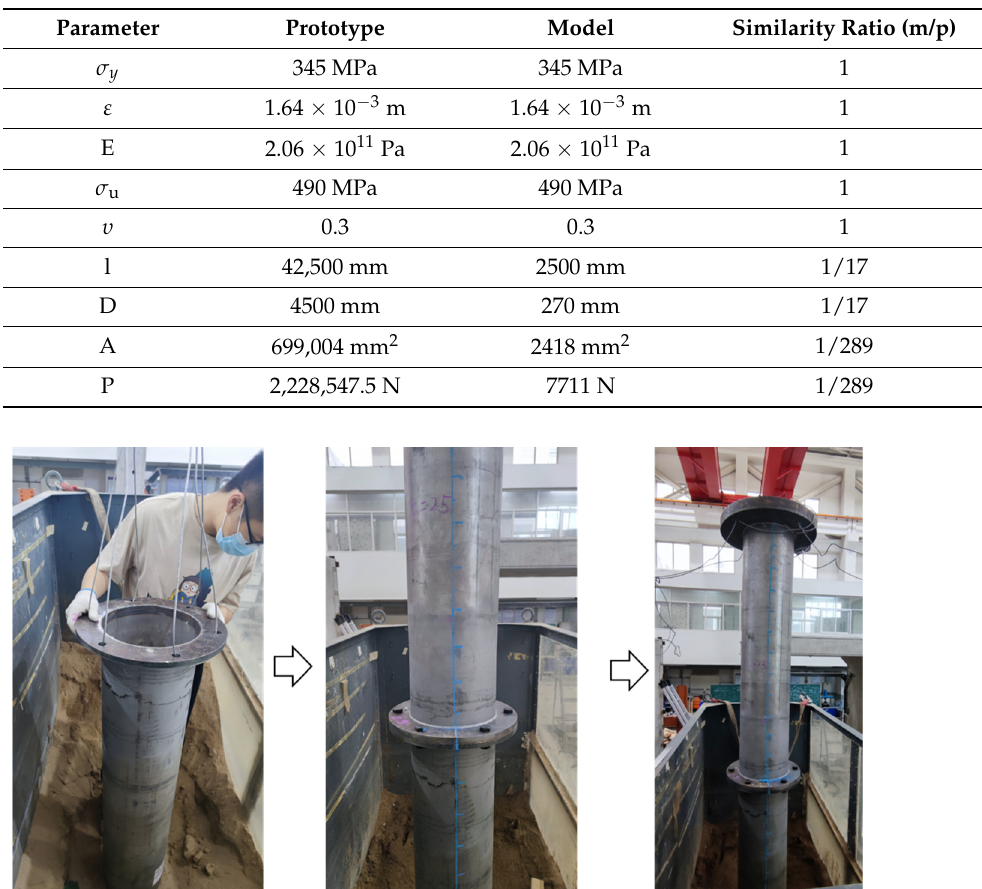
Figure 24. Sensor placement El Centro and Nihonkai-Chubu seismic waves are selected as seismic loads. In order to ensure the safety of the experiment, the peak value of the seismic wave is adjusted to 0.04 g and 0.1 g, respectively. The hydraulic vibration table and control equipment for loading are shown in Figure 25.